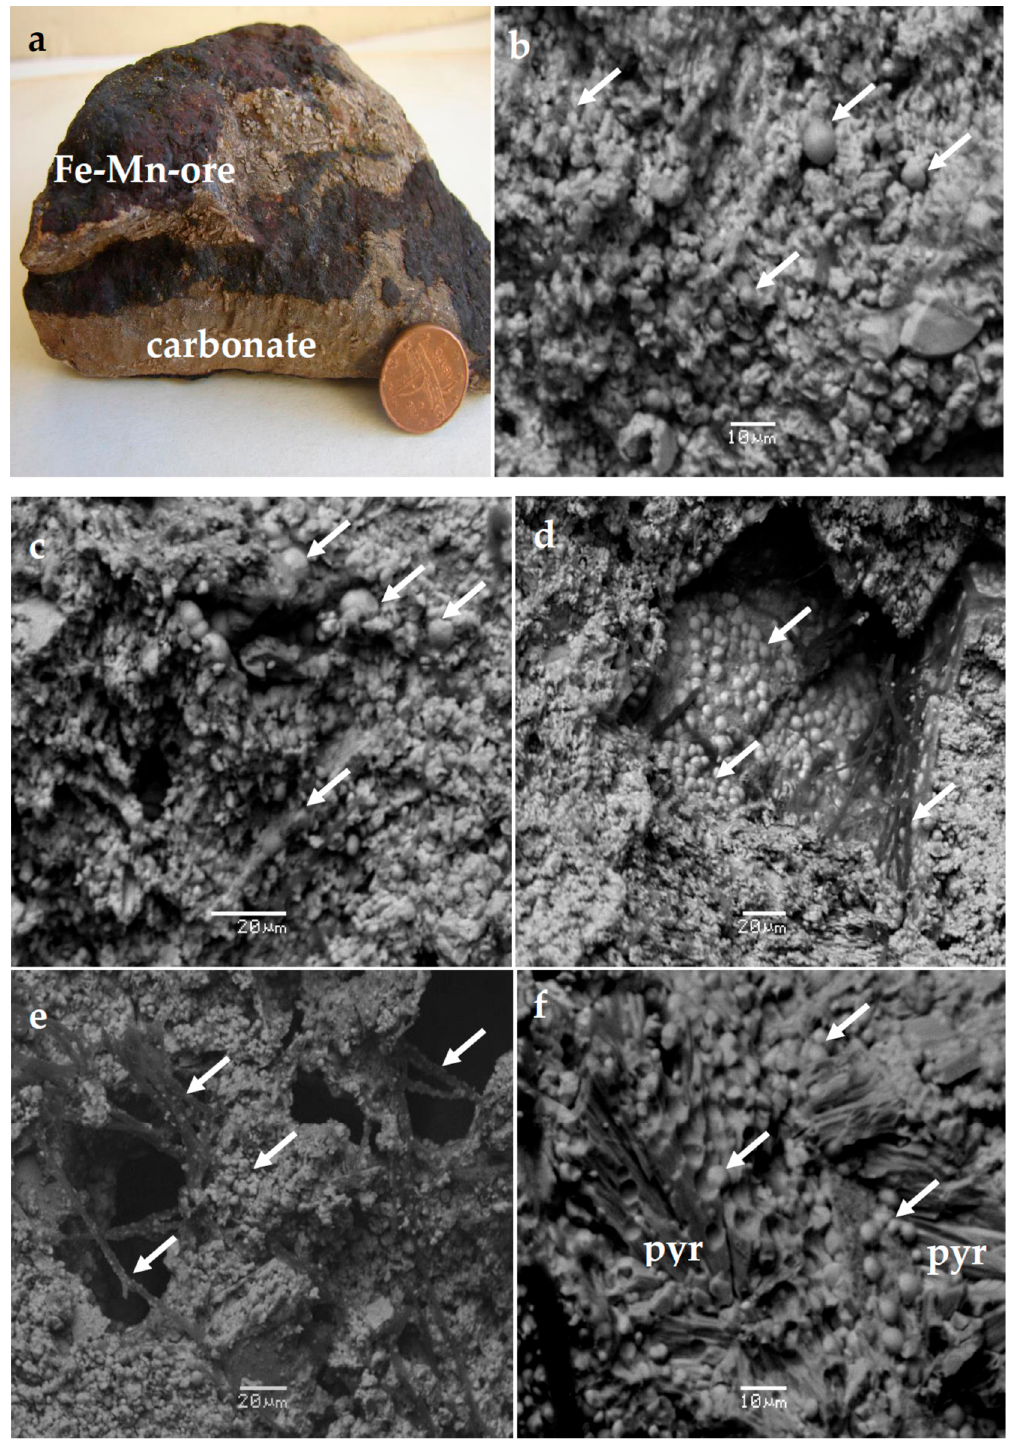
Figure 5. ( a ) Photograph of folded Fe-Mn ore sample hosted in limestone, from the Legrena valley, Lavreotiki. Back scattered images from unpolished samples showing ( b – d ): Consortium of bacteria fossils (white arrows) including abundant sphere or coccus (monococcus, diplococcus or packets) and filaments (5 d , e ) within a matrix of goethite. Goethite coated spherical fossilized bacteria and/or removed mold spheroidals on pyrolusite crystals (pyr) is remarkable ( 5f ; see Table 2). Table 2. Representative scanning electron microscope (SEM)-energy dispersive spectroscopy (EDS) analyses from the Fe-Mn-mineralization at the Legrena valley, Lavrion. Small Nodules (Figure 3) Oxide wt %